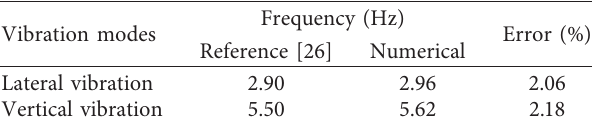
Figure 6: Vibration modes of the bridge girder. (a) f (f) f 6 � 19.87Hz. Table 2: Natural frequencies of the bridge girder.